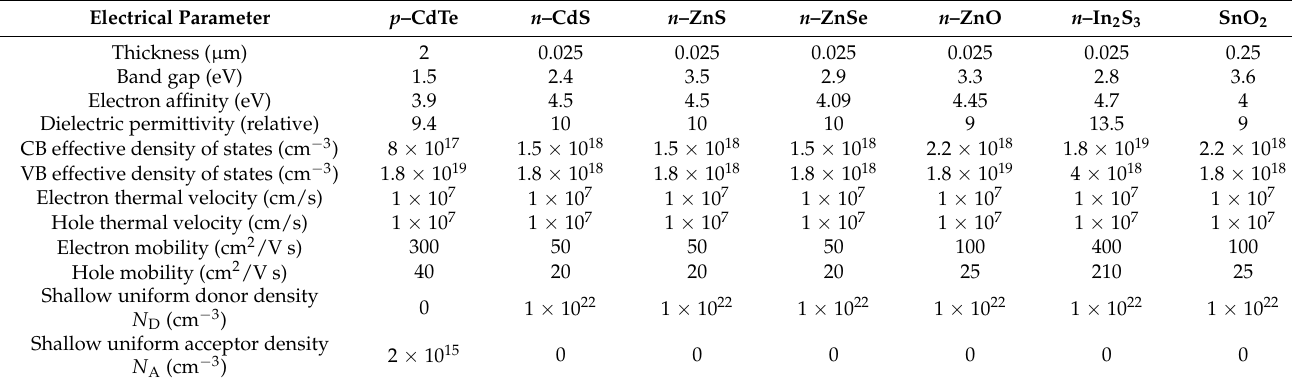
Table 3. The electrical parameters for the thin–film solar cell at 300 K.